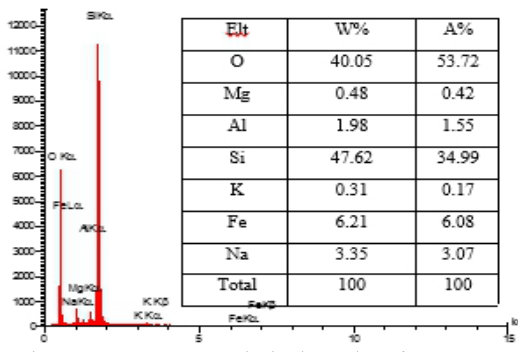
Fig. 2. SEM–EDX analytical results of